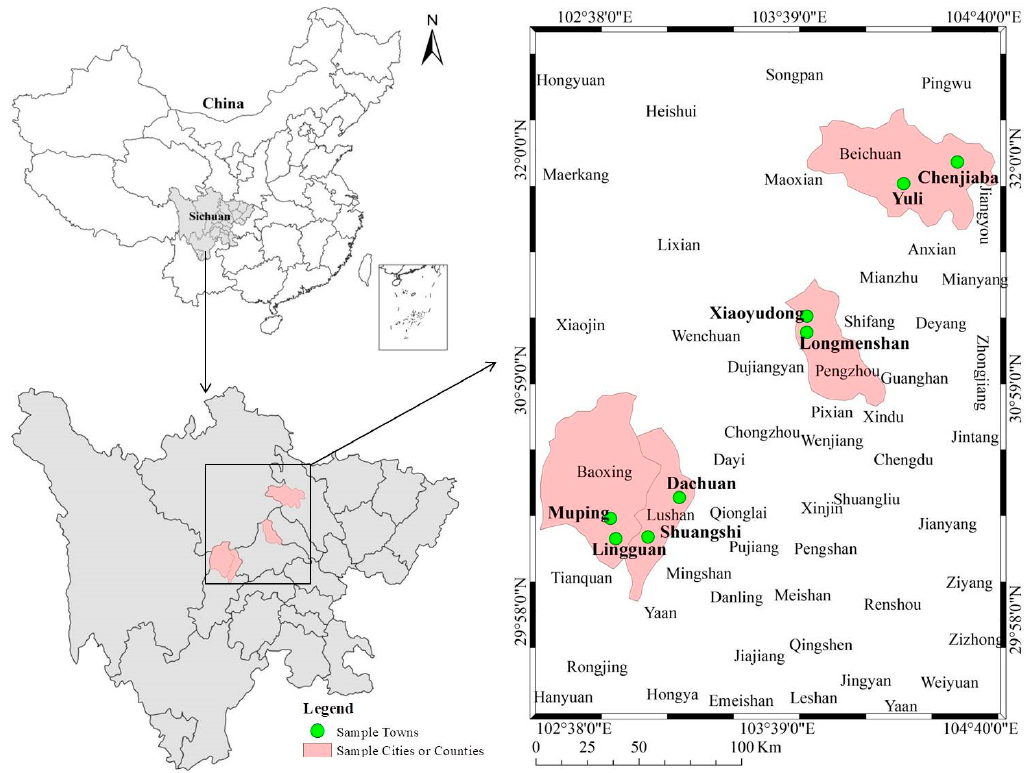
Figure 1. Location map of sample counties and towns.